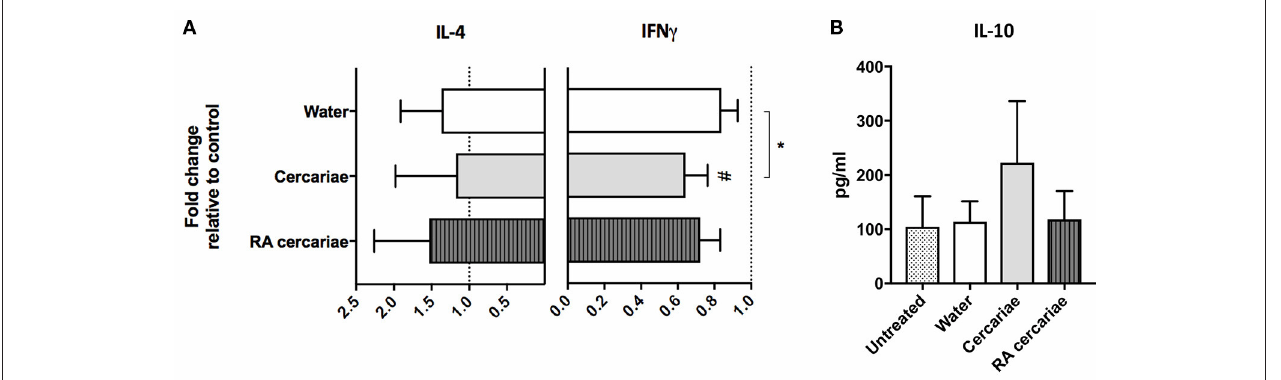
FIGURE 6 | Stimulation with cercariae reduces pro-inflammatory potential of DDCs. Emigrated DDCs were co-cultured with CD4 + T cells to assess immunomodulatory potential. Data shown as percentages IFN γ or IL4 producing CD4 + T cells cultured with ex vivo stimulated DDCs relative to CD4 + T cells cultured with DDCs from untreated skin after PMA/ionomycin stimulation. Mean ± SEM. * p < 0.05, using paired Student’s T -test (A) . IL-10 production by CD4 + T cells after co-culture with DDCs. ELISA on culture supernatants after 24h stimulation with anti CD3/28 (B) . Data shown in pg/ml. Mean ± SEM.